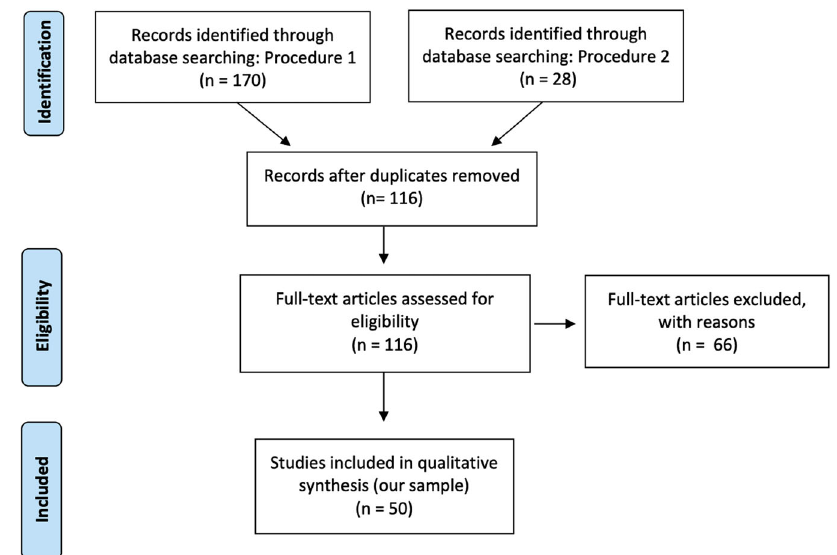
Fig. 1 Prisma fl ow diagram for paper